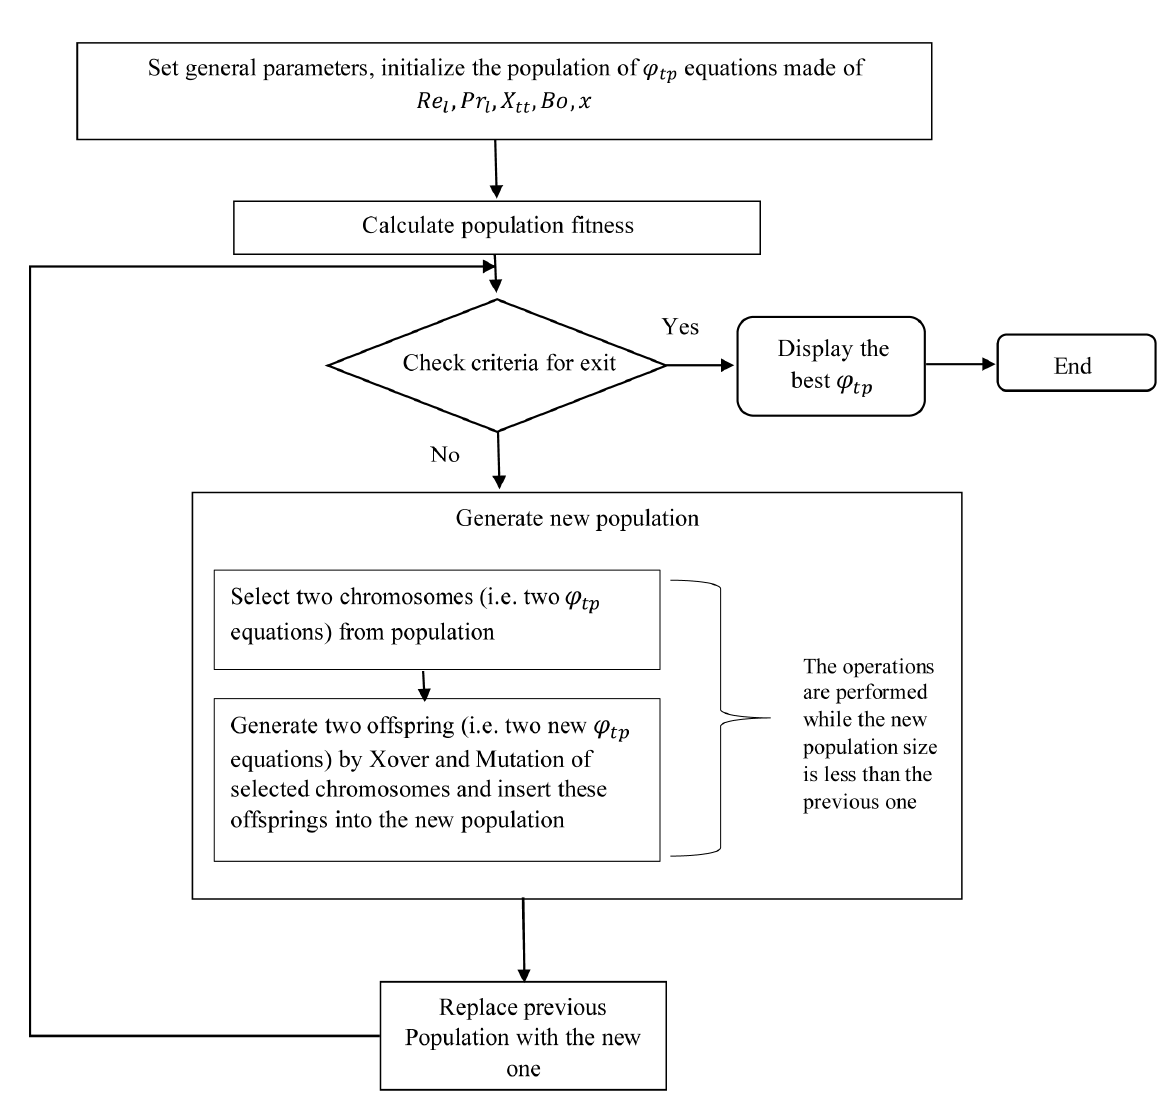
Figure 1. The present genetic programming flowchart.